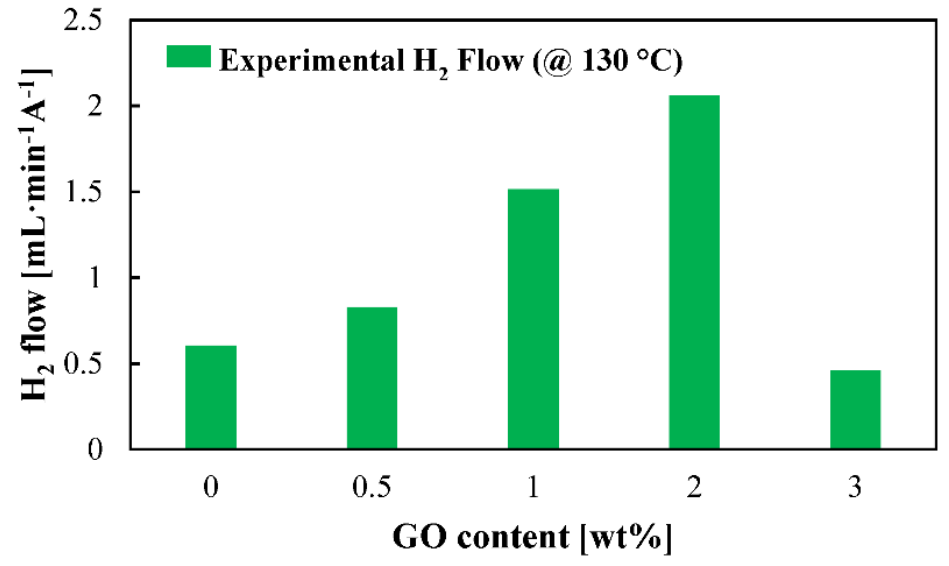
Figure 6. Hydrogen production rate at 130 °C for the studied membranes. Measurements carried out at a cell voltage of 0.6 V.